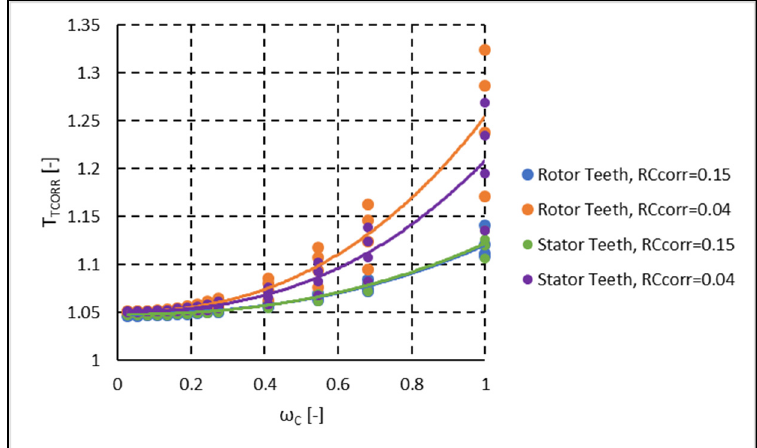
Figure 9. Total temperature trendlines.